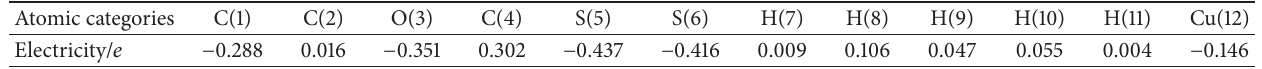
Table 6: Mulliken charge distribution of ethyl xanthate ion and the ethyl xanthate ion + Cu 2+ .